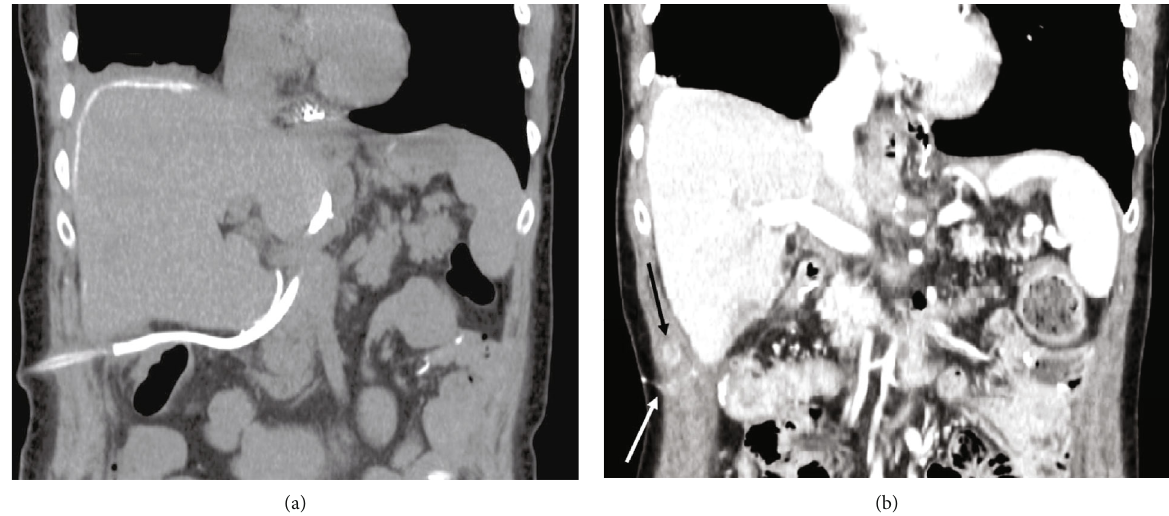
Figure 6: Coronal noncontrast (a) and postcontrast (b) CT reconstructions demonstrating a new vascular nodule (black arrow) in close proximity to the drain tract with the residual barium demarcating tract (white arrow).